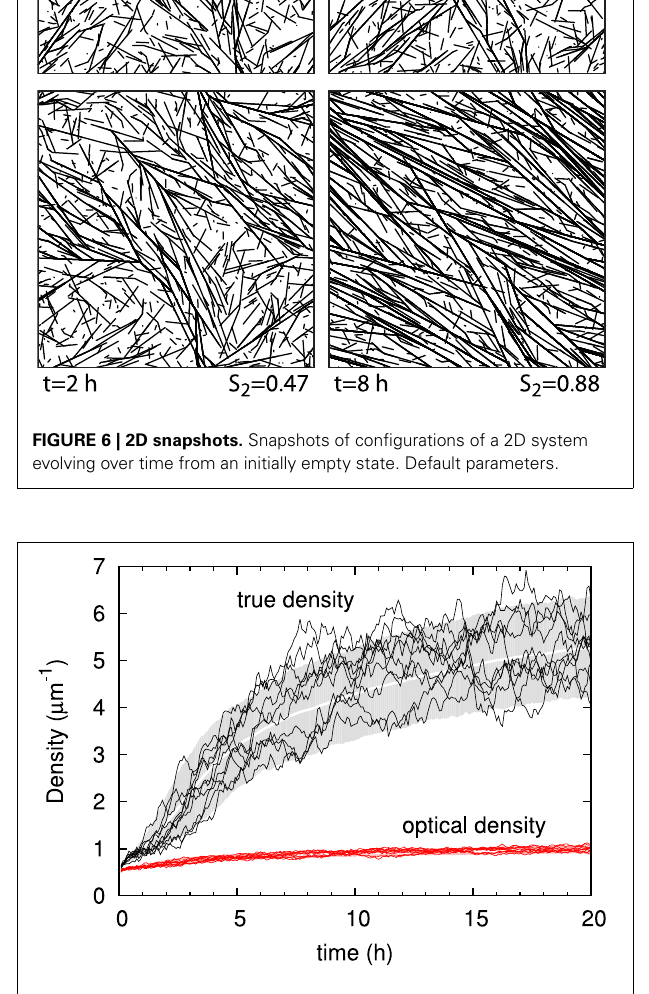
FIGURE 7 | Time evolution of microtubule density. The gray zone indicates the actual microtubule density over time of the 10–90% interval of n = 1000 independent runs, with the average density indicated in white. Black traces show the densities recorded in 10 individual runs. Below, in red, are the optical densities of the same ten runs (a similar band in pink indicates the group statistics, but the band is so narrow that it is hardly visible). Default